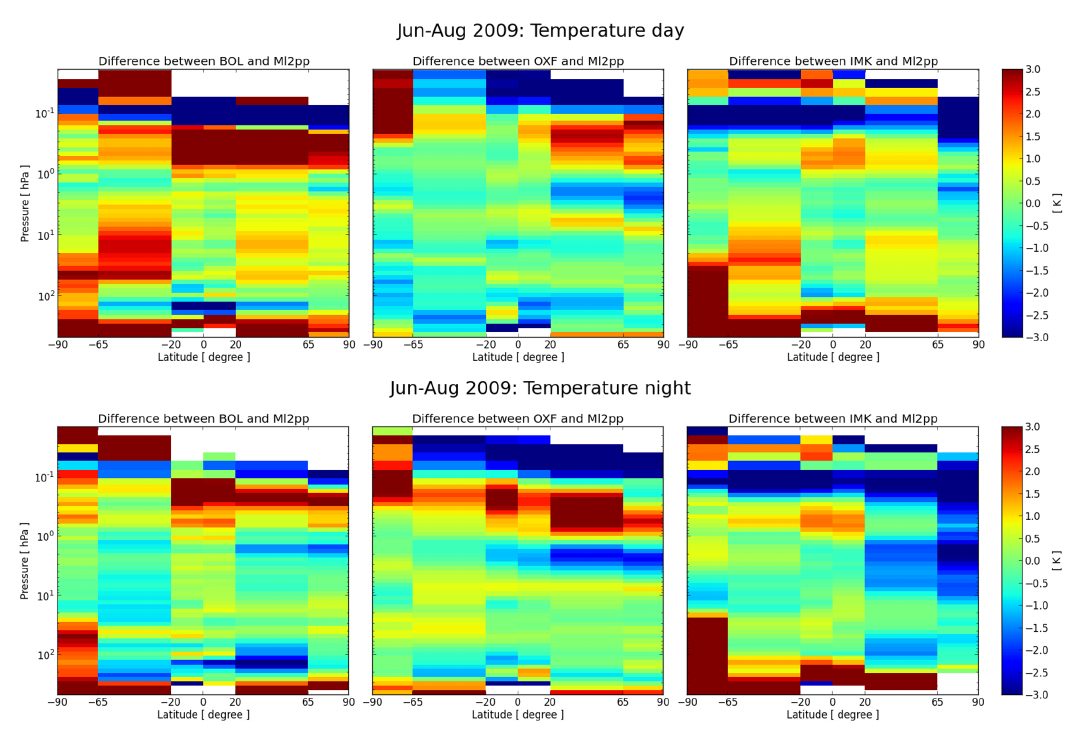
Figure 2: Maps of the differences between the temperature zonal means of BOL and ML2PP (left plots), OXF and ML2PP (center plots), IMK and ML2PP (right plots) for June-July-August 2009 period; upper plot: daytime conditions, lower plot: nighttime